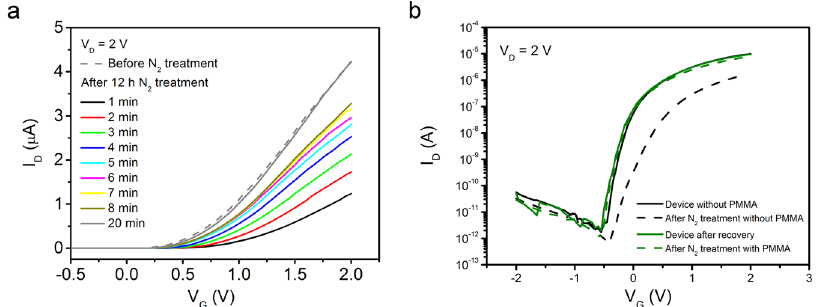
Figure 3. Stability of EDL TFTs. ( a ) Transfer characteristics of the TFT gated with 200-nm thick SiO 2 sputtered at 85 W before (dashed line) and recovering from (solid lines) a treatment in dry N 2 for 12 hours. ( b ) Transfer characteristics of IGZO EDL TFTs with and without a capping layer of 400 nm PMMA, before and after a dry N 2 treatment for 12